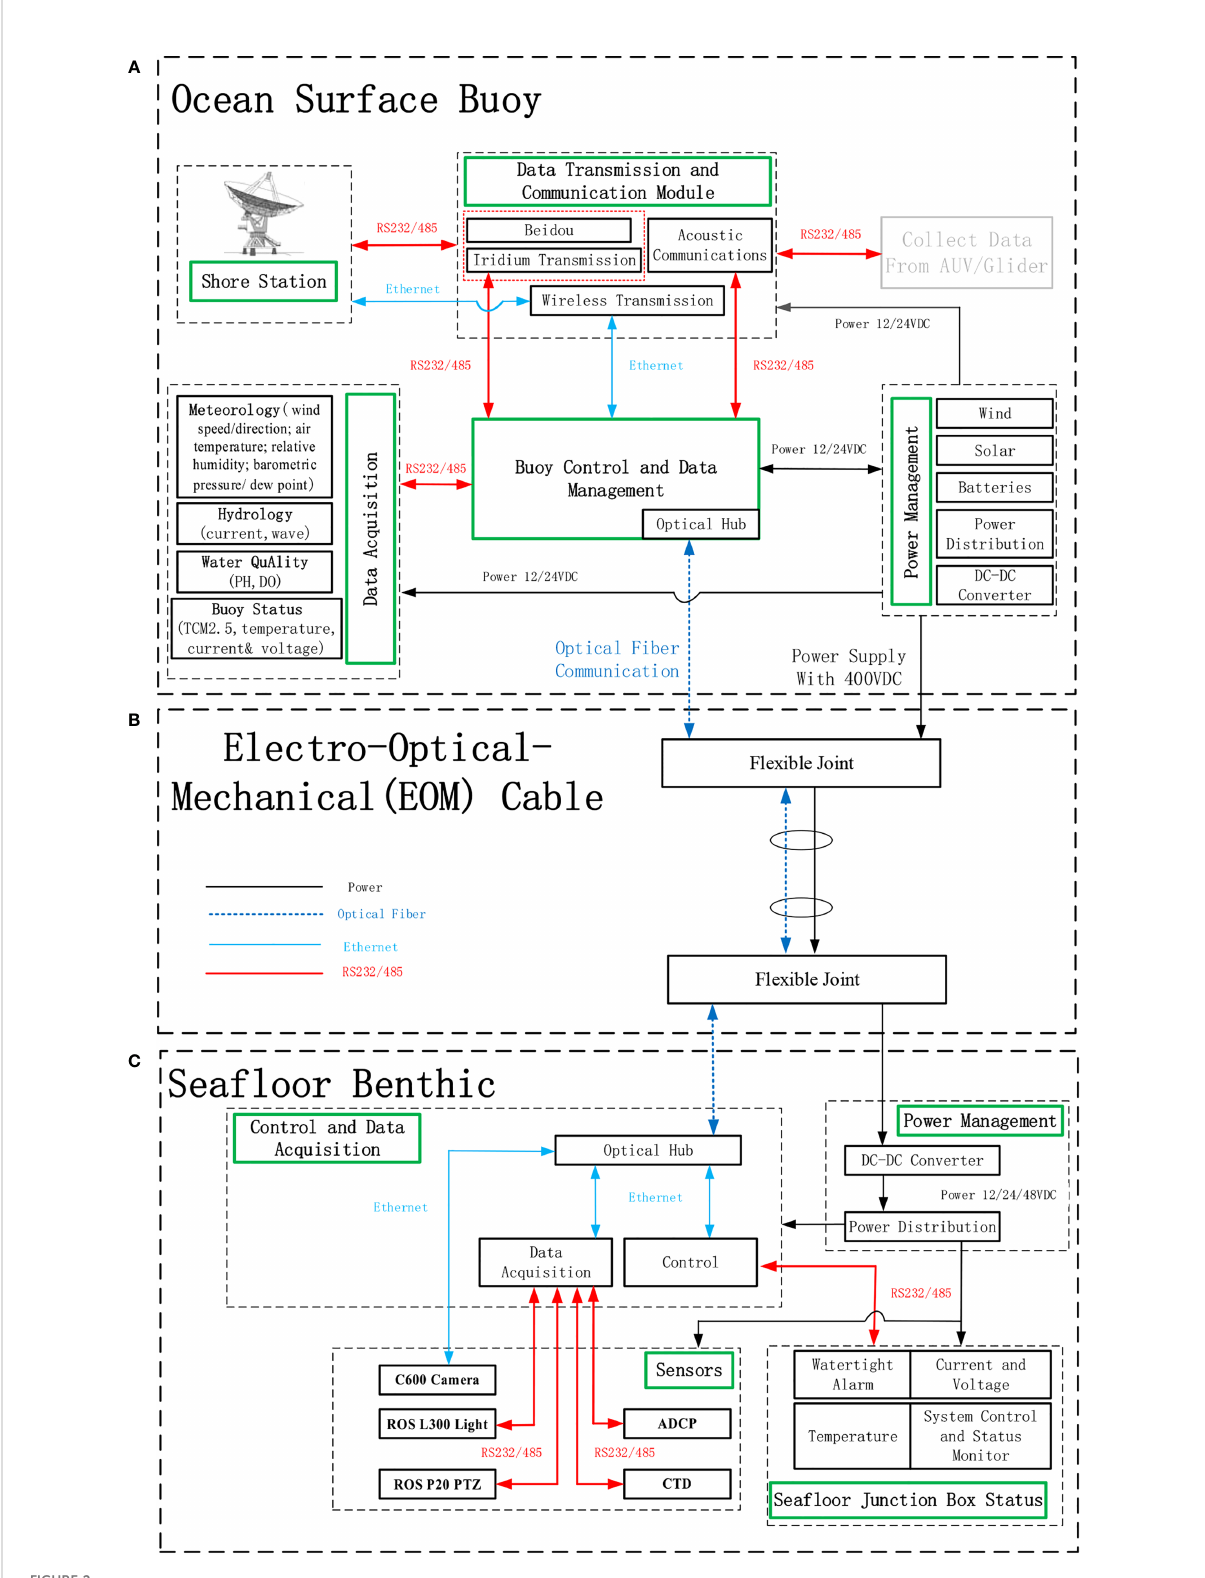
FIGURE 2 Detailed architecture of MBOSBC: (A) mooring buoy; (B) sea fl oor junction box; (C) EOM cable for mooring and power and data